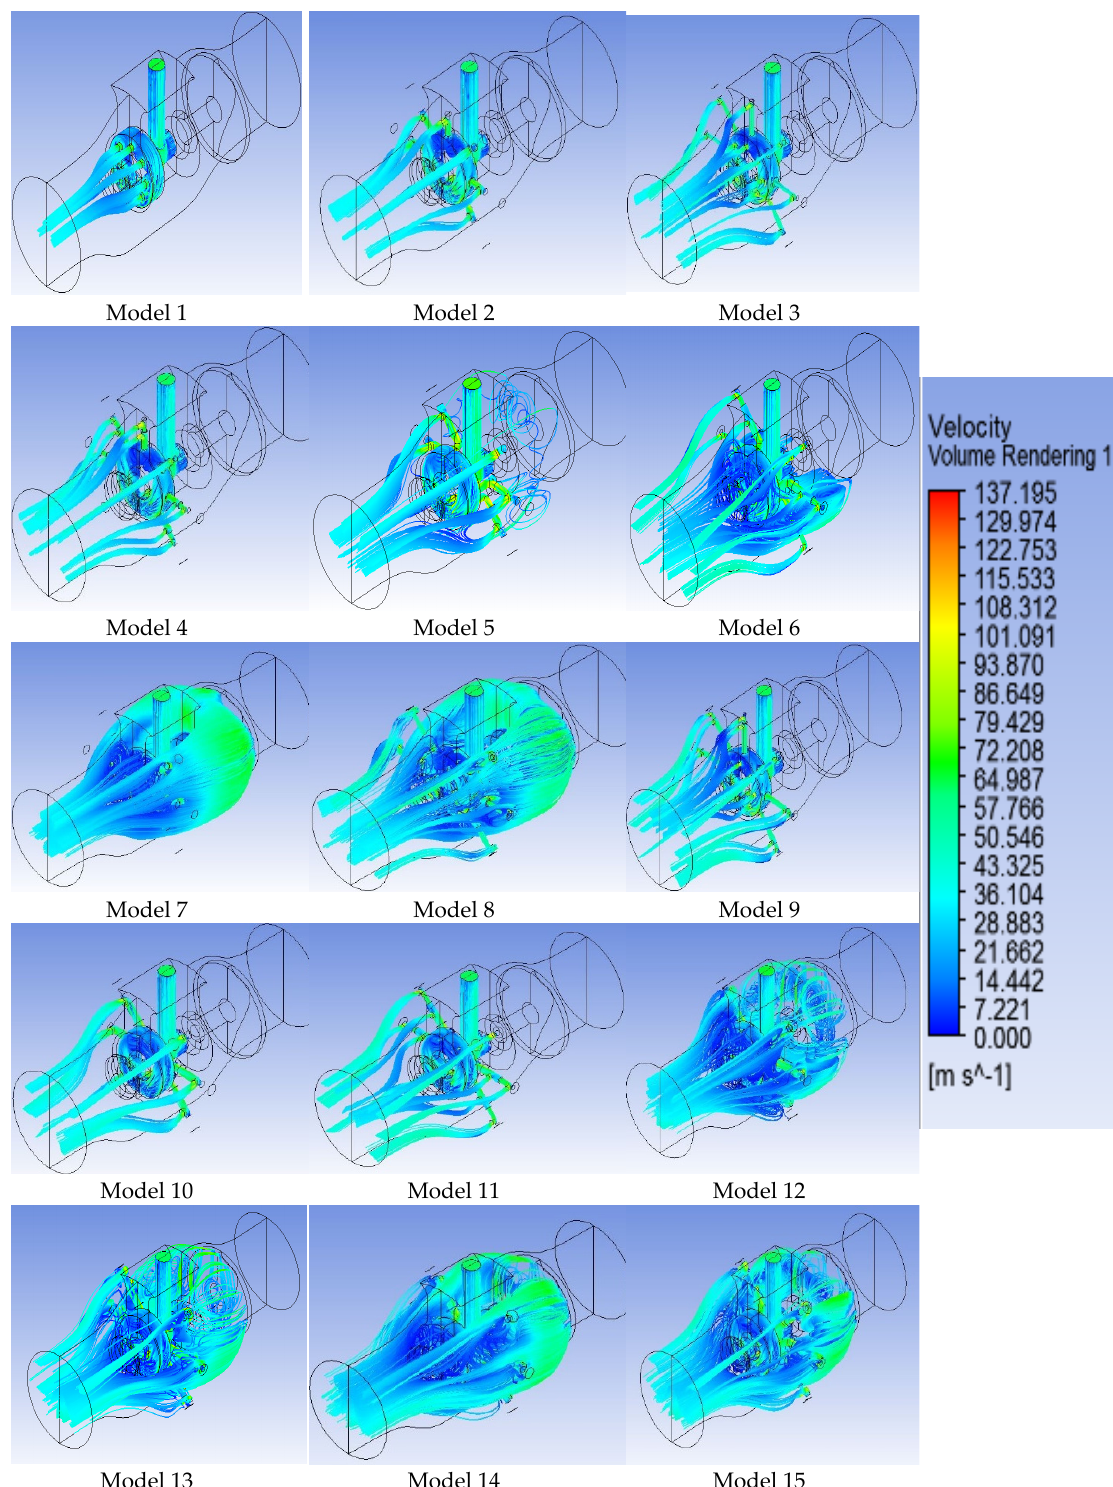
Figure 14. Velocity streamline (with 1000 points at CNG inlet) for new mixer models under air-CNG ratio 34.15.